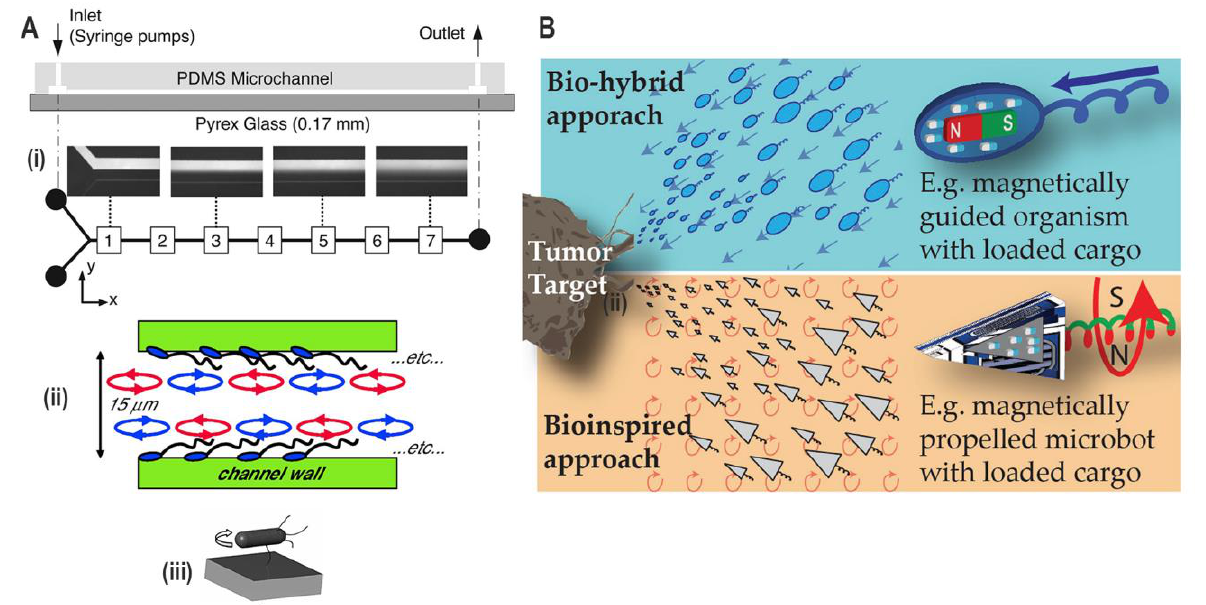
FIGURE 9: Applications derived from research into bacterial motility. (A) Microfluidic mixing. (i) Free-swimming bacteria enhance mixing across the laminar flow in the Y-shaped microfluidic device, as indicated in the boxes numbered from 1 to 7. Reproduced from [67]. (ii) A monolayer of bacteria (aka ‘bacterial carpet’) with a freely rotating flagellar bundle is attached to the channel wall which enhances mixing. Reproduced from [70]. (iii) A nanoengineered bacterial strain which expresses biotin at the tip of the flagella binds to the streptavidin- coated glass surface. It results in the situation where bacteria are tethered via the flagella, and the whole-cell body rotates to induce mixing in microfluidic channels. Reproduced from [71]. (B) Bio-hybrid and bio-inspired microrobots. Drug-loaded cargoes are attached to the motile bacteria containing magnetic nanoparticles or to artificial magnetic microrobots. These microrobots are then guided to the tumour target applying a magnetic field. Reproduced from